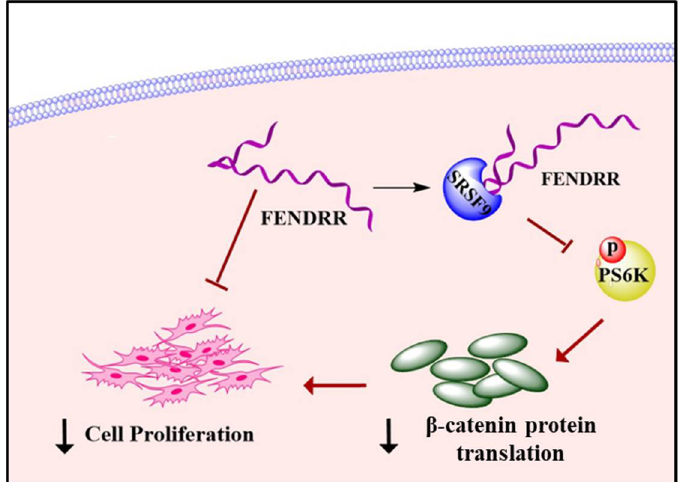
Figure 7. A model showing that FENDRR inhibits fibroblast proliferation by binding SRSF9 and reducing β-catenin protein